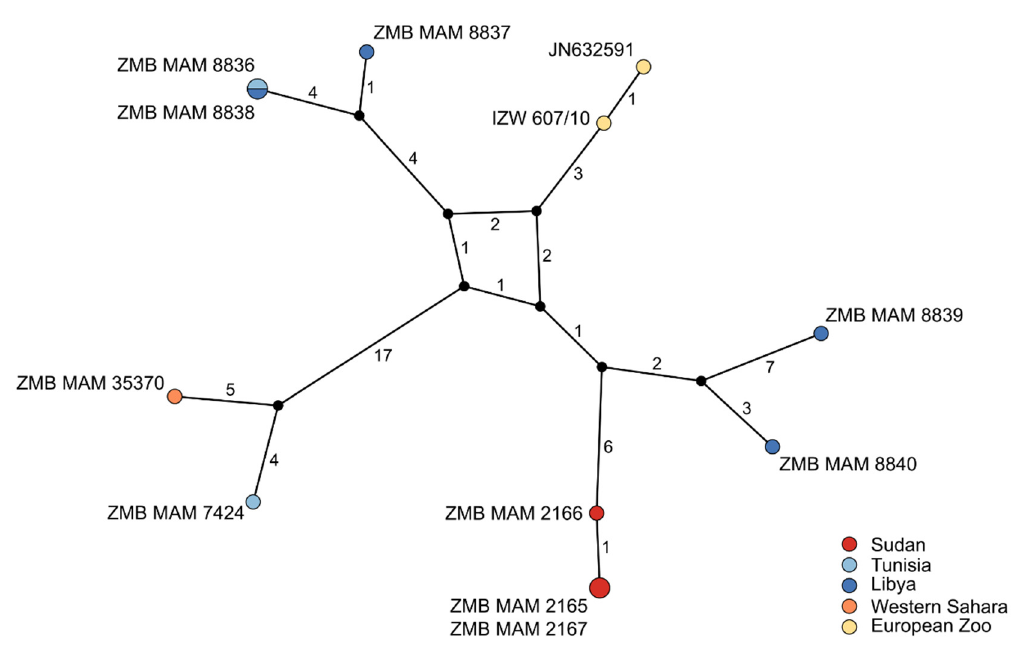
Figure 6. TCS network of twelve addax mitochondrial genomes. The TCS network of the complete mitochondrial genomes generated in POPART v1.7 takes only positions into account that are present in all sequences while excluding ambiguities/missing data (alignment length: 16,685 bp). Numbers and black circles represent substitutions and unsampled haplotypes, respectively. Circle size corresponds to the number of specimens assigned to a haplotype.